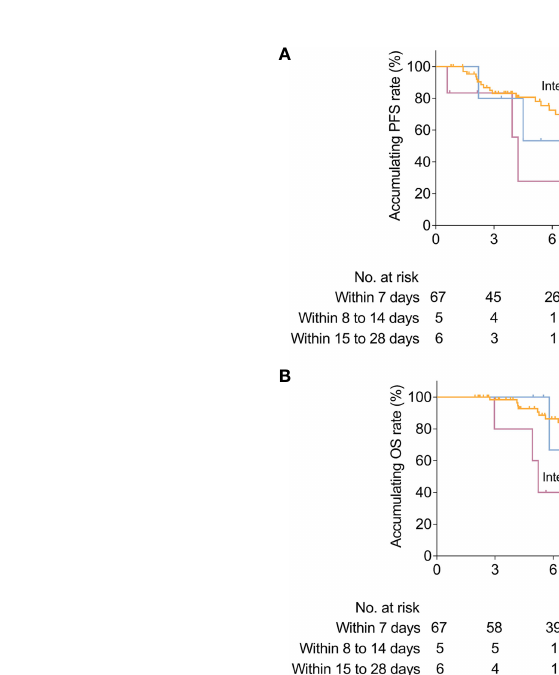
FIGURE 4 Correlation of timing between camrelizumab administration and TACE with survival. Correlation of timing between camrelizumab administration and TACE with PFS (A) and OS (B) in HCC patients receiving camrelizumab plus TACE. HCC, hepatocellular carcinoma; TACE, transarterial chemoembolization; PFS, progression-free survival; OS, overall survival.